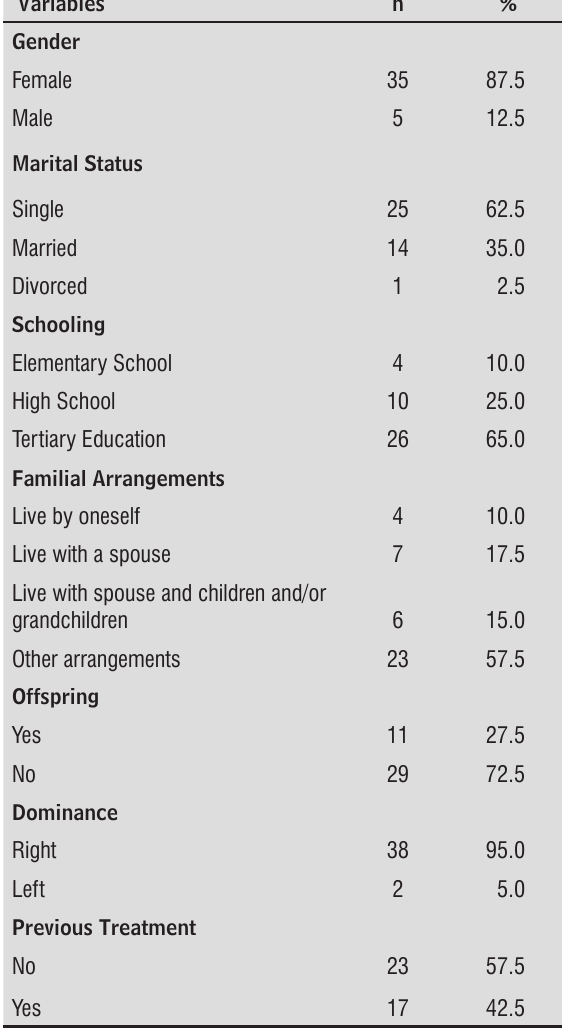
Table 1 - Subjects’ sociodemographic characteristics Table 2 - Characteristics of subject’s treated with TENS and